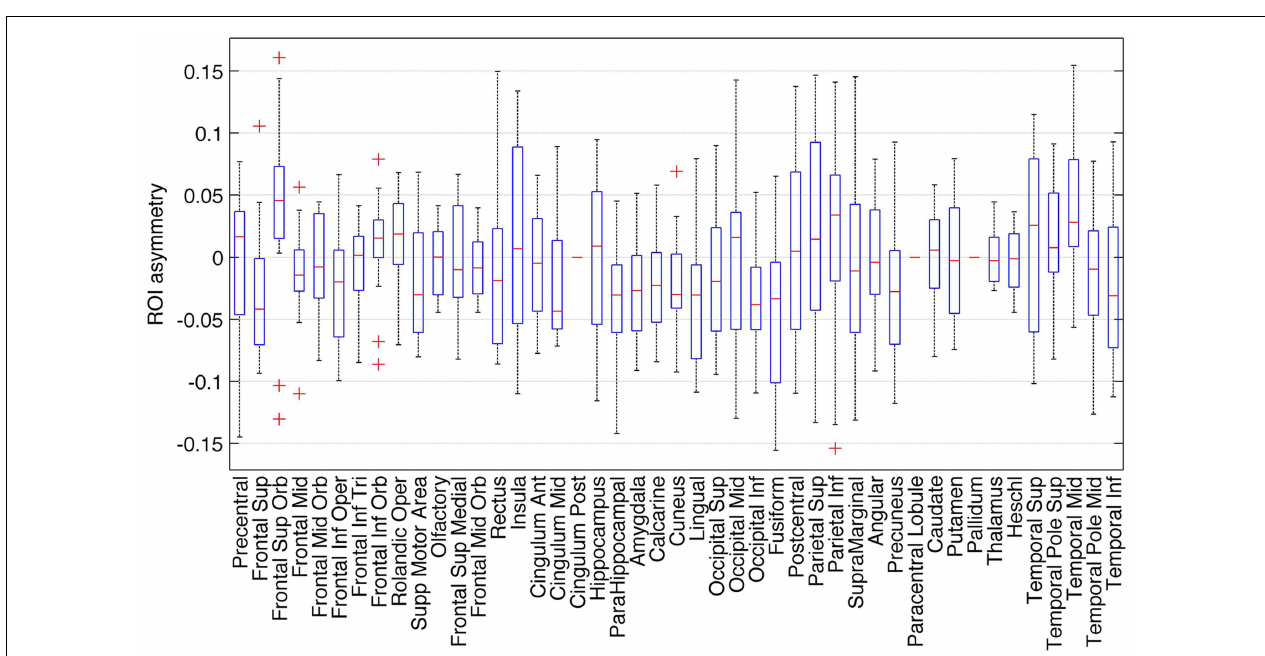
FIGURE 2 | Box-plot demonstrating the distribution of asymmetry indices for all ROIs . Positive asymmetry indices represent a leftward asymmetry.